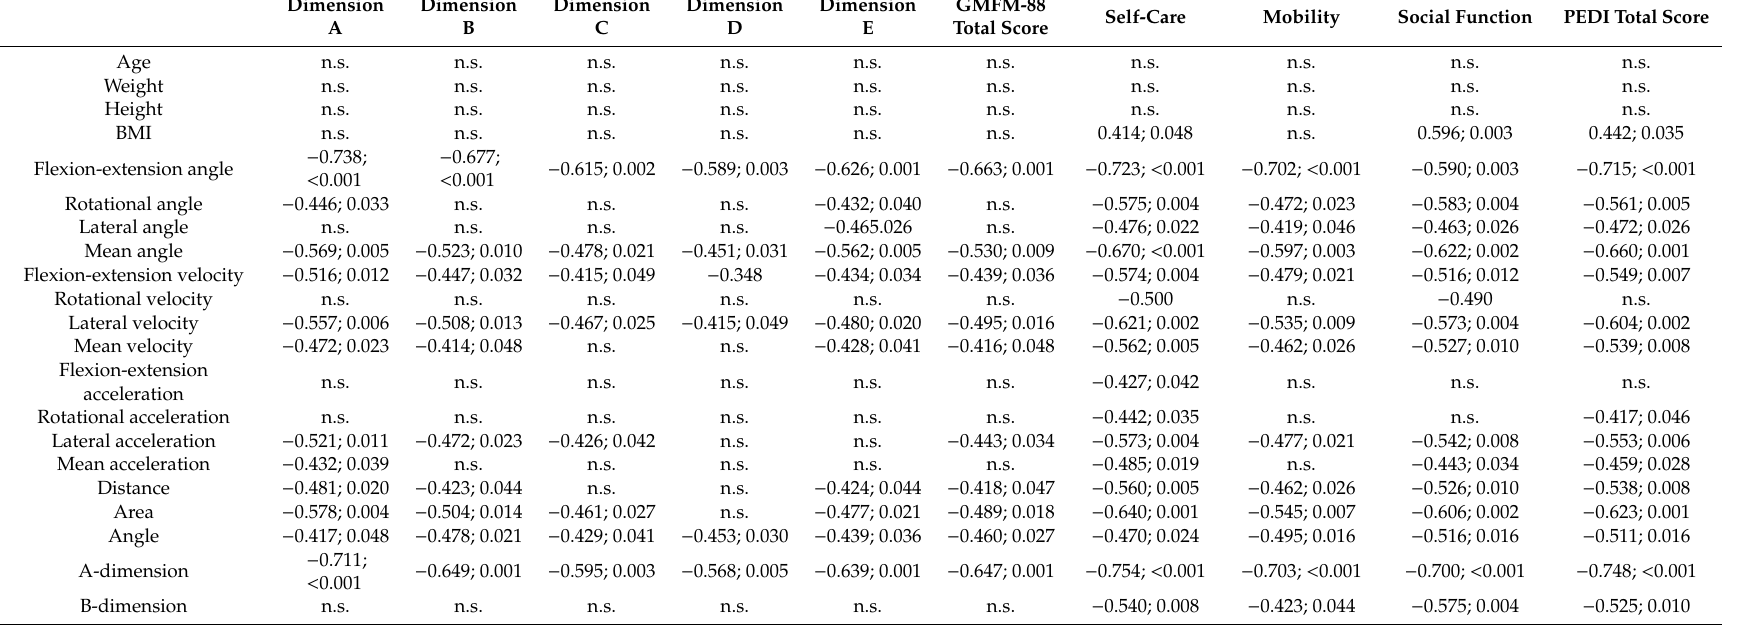
Table 3. Correlations between sociodemographic, new test outcomes, and functional scores in the CP group ( n = 24). Dimension Dimension Dimension Dimension Dimension GMFM-88 Self-Care Mobility Social Function PEDI Total Score A B C D E Total Score Age